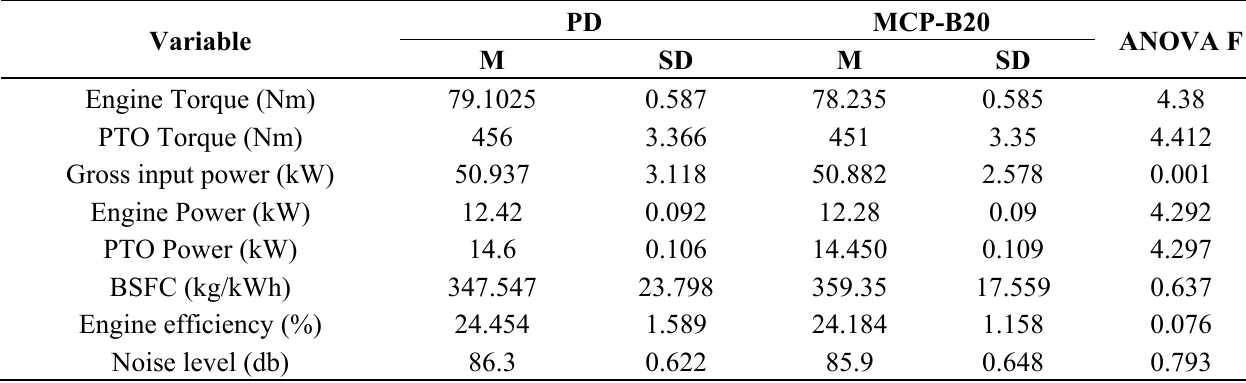
Table 4. Descriptive statistics and ANOVA summary for tractor engine performance and emissions at WOT, peak PTO torque (1500